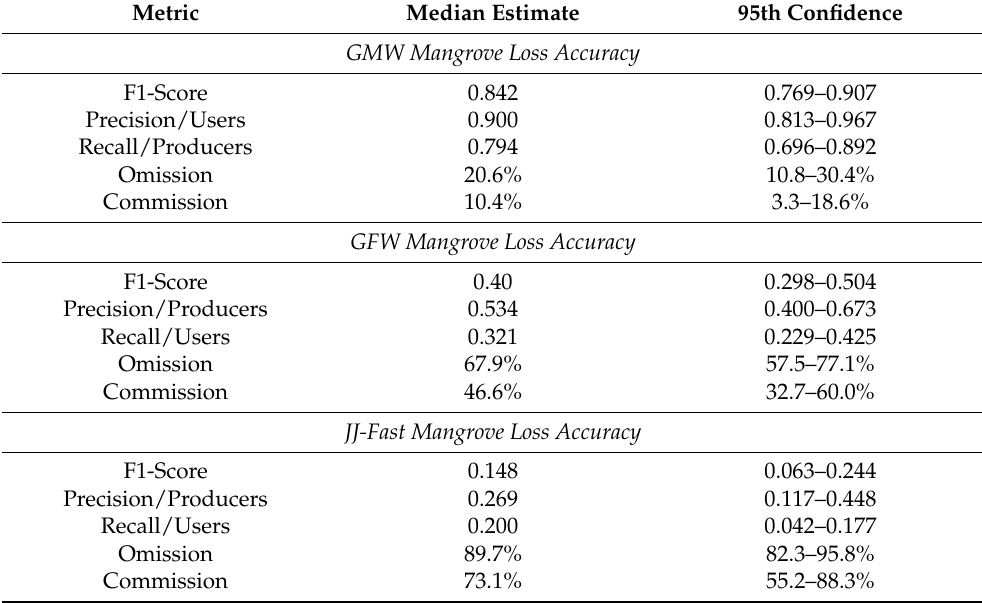
Table 6. Comparison of the accuracy of mapping mangrove loss between the GMW Mangrove Loss Alerts (this study), the JJ-FAST alerts [34] and GFW alerts [32,33]. Metric Median